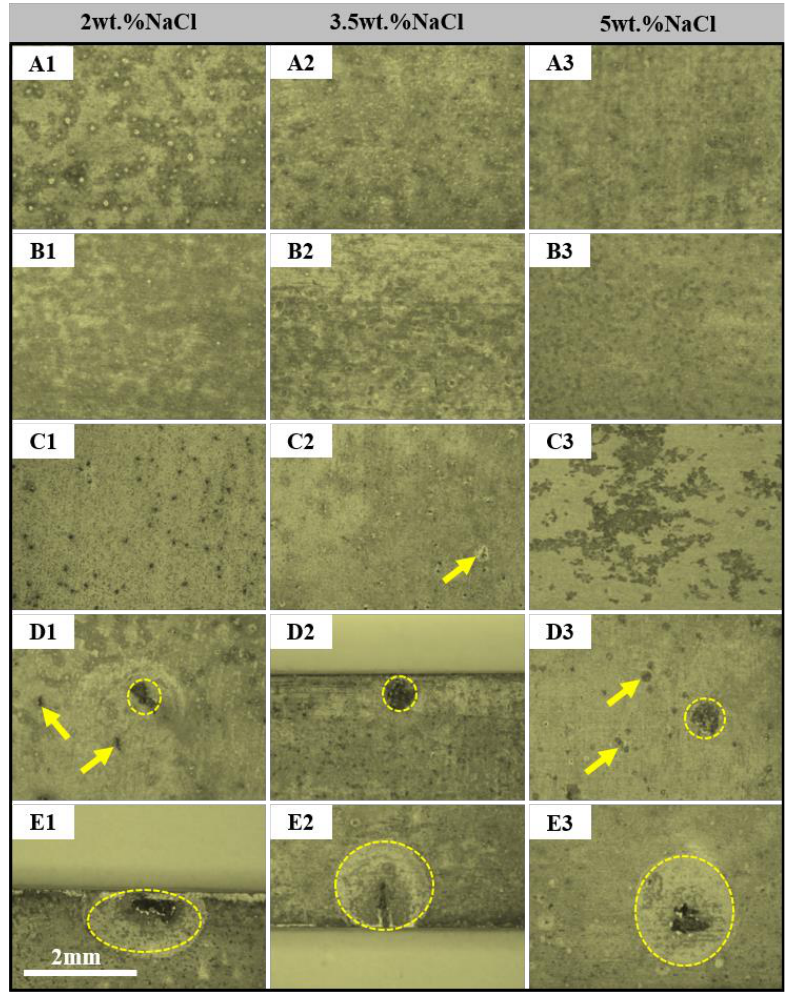
Figure 3. The macroscopic morphology of specimens immersed in different concentrations of NaCl solution for 7 days ( A : 2A97-T3; B : 2A97-T6; C : 2024-T4; D : 2060-T8; E : 2099-T83).